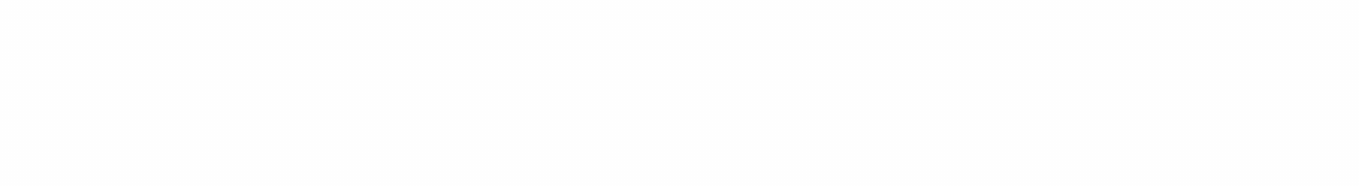
FIGURE 2 Phase diagram (in Oo, Oo coordinates) of the systems (1)-(3) in one-dimensional-plane case. The values of other parameters are the same as in the Fig. 1. The domain "TW" corresponds to the "travelling waves"; "E" corresponds to the "echo-waves"; "1", "2", "3", "4" are in accordance with formation of the fibrin pattern consisting of corresponding number of elements (stripes). [o] nM, [q0] 10 -2